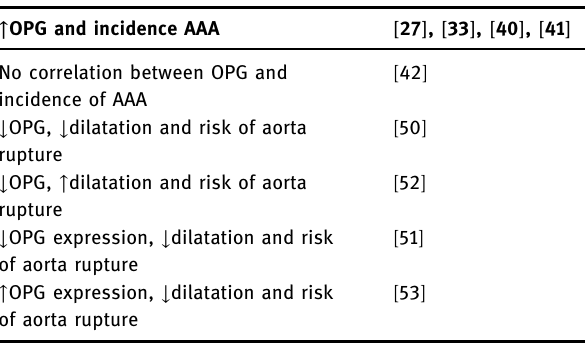
Table 2: Osteoprotegerin ( OPG ) and progression of abdominal aorta aneurysms ( AAA